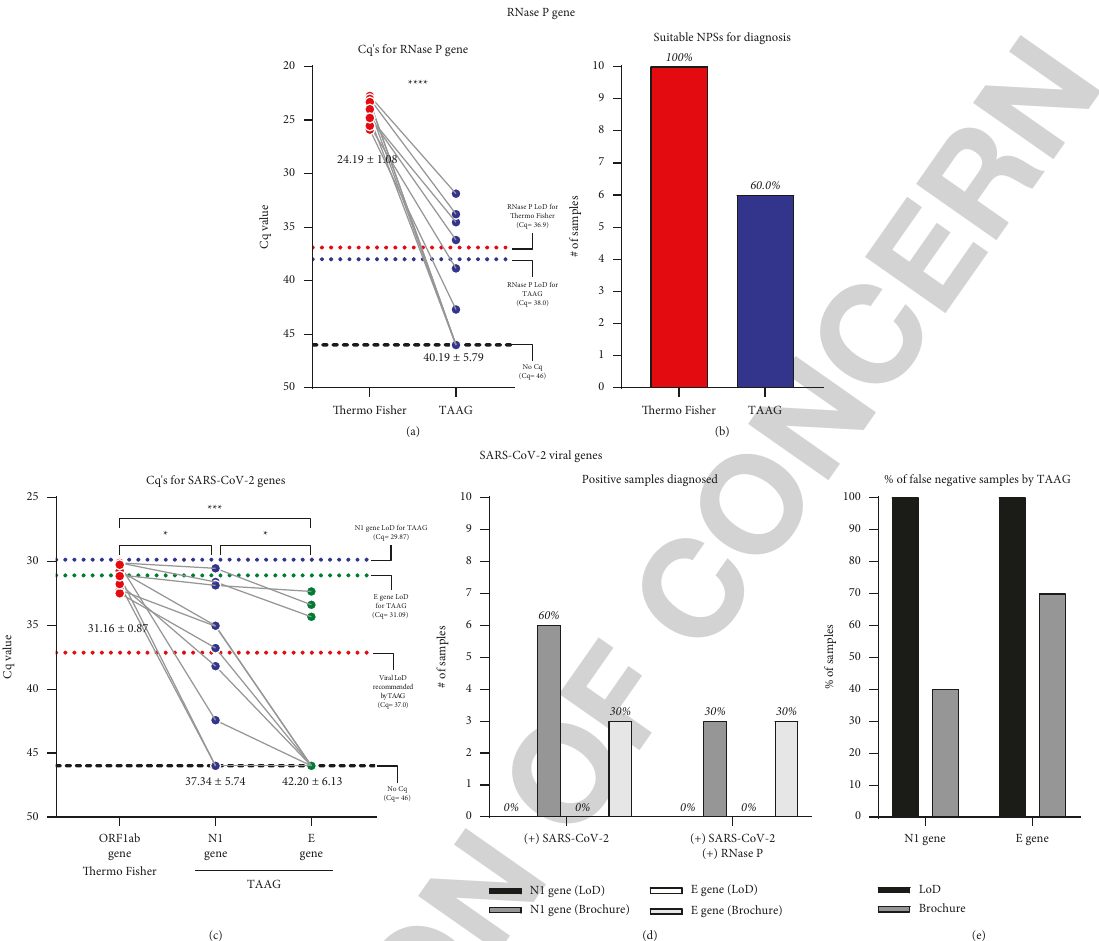
Figure 3: Comparative analysis between Thermo Fisher and TAAG RT-qPCR kits with a known Cq value close to 30 (for ORF1ab gene probe, Thermo Fisher). The comparison was made for the same NPSs using the previously optimized volume of 2 μ l of total RNA extracted. The upper section of the figure represents the analysis for the RNase P internal reference gene probe amplification from 10 NPSs previously diagnosed as SARS-CoV-2 positive by the Thermo Fisher RT-qPCR kit with a Cq value close to 30. (a) Paired comparison of Cq value of RNase P internal reference gene probes from Thermo Fisher and TAAG kits. In graph, the horizontal red-dotted line represents the LoD for RNase P reference gene probe (Cq � 36.9) by Thermo Fisher kit, and the horizontal blue-dotted line represents the maximum recommended Cq value (Cq � 38) by the manufacturer for suitable sample diagnosis using TAAG RT-qPCR kit RNase P reference gene probe. Samples with Cq � 46 denote no amplification (indicated in the graph by a black broken line). For statistical analysis, a paired two-sided student’s t- test was applied ( n � 10 NPSs, ∗∗∗∗ p < 0 . 05). (b) Number of suitable samples diagnosed with a Cq value within the detection range of the internal reference gene probes. The lower section of the figure represents the analysis for the viral gene probe amplification from 10 NPSs previously diagnosed as SARS-CoV-2 positive by the Thermo Fisher RT-qPCR kit with a Cq value close to 30. (c) Paired comparison of Cq value of viral gene probes from Thermo Fisher (ORF1ab viral gene probe) and TAAG (N1 and E viral gene probes) kits. In graph, the horizontal colored-dotted lines blue, green, and red, respectively, represent the experimental LoD for N1 gene (Cq � 29.87), E gene (Cq � 31.09), and ORF1ab gene (Cq � 37.14) viral gene probes. Samples with Cq � 46 denote no amplification (indicated in the graph by a black broken line). For statistical analysis, paired one-way ANOVA-test with multiple comparison test analysis was applied. (n � 10 NPSs, ∗∗∗∗ p < 0 . 05). In graphs (a) and (c), the mean ± standard deviation (mean ± SD) is indicated for the viral gene probe amplification obtained for all the samples evaluated. The line linking the spots indicate the paired result obtained for the same sample assessed by both RT-qPCR kits. (d) Summary of the number of positive NPSs diagnosed using TAAG RT-qPCR kit considering the RNase P internal control amplification. In the graph, “(+) SARS-CoV-2” represents a positive virus diagnosis, and “(+) RNase P” represents the amplification of the internal reference gene. (e) Summary of the percentage of false negative NPSs diagnosed by TAAG RT-qPCR kits applying brochure or experimental LoD